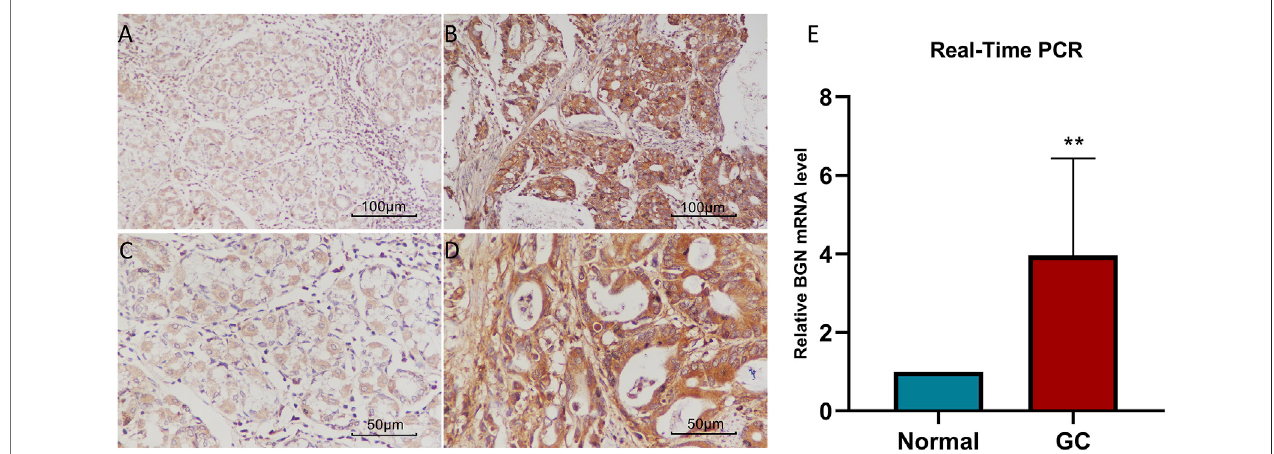
FIGURE 6 | The association between BGN expression and prognosis of patients with Gastric Cancer. (A) Overall Survival. (B) Disease Speci fi c Survival. (C) Progress Free Interval. (D) Results of multivariate Cox regression analysis of the relationship between Overall Survival and clinicopathological variables in patients with gastric cancer. HR: Hazard Ratio. CI: Con fi dence Interval.